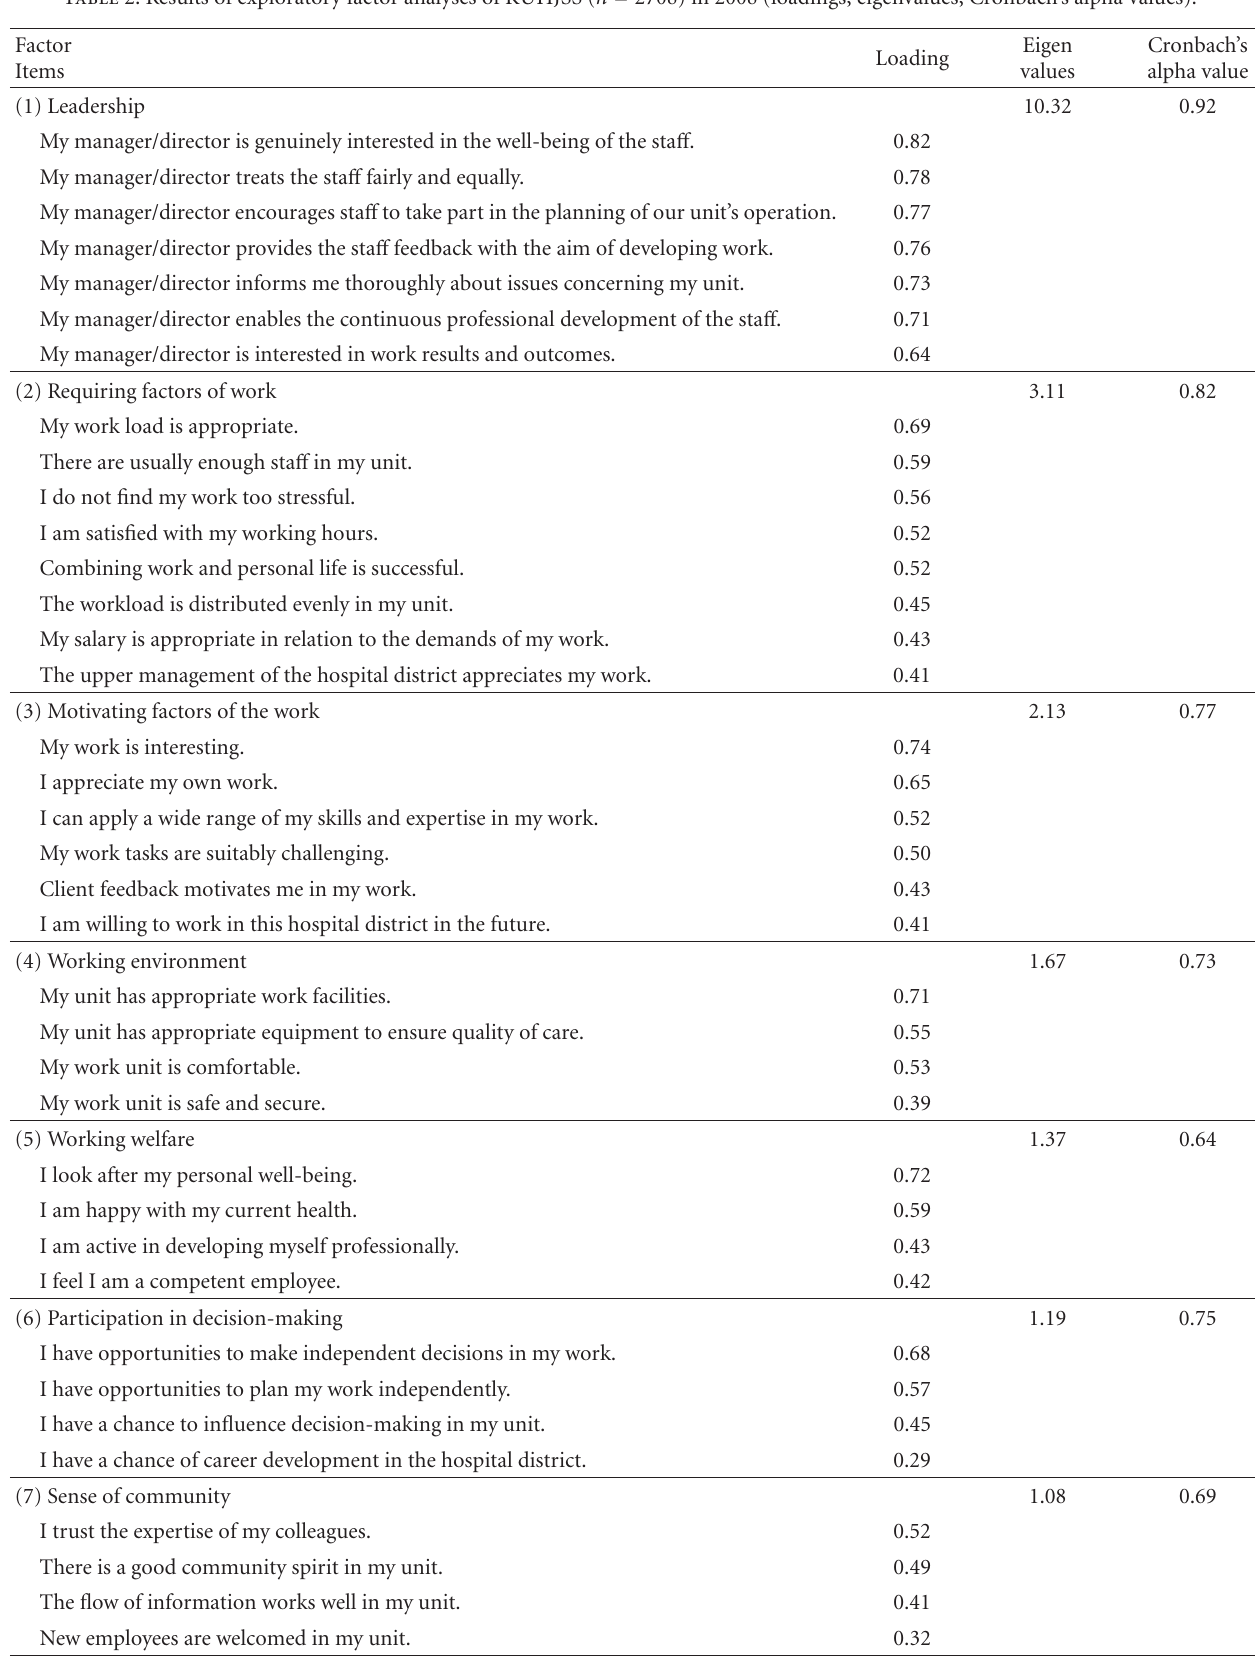
Table 2: Results of exploratory factor analyses of KUHJSS ( n = 2708) in 2008 (loadings, eigenvalues, Cronbach’s alpha values).